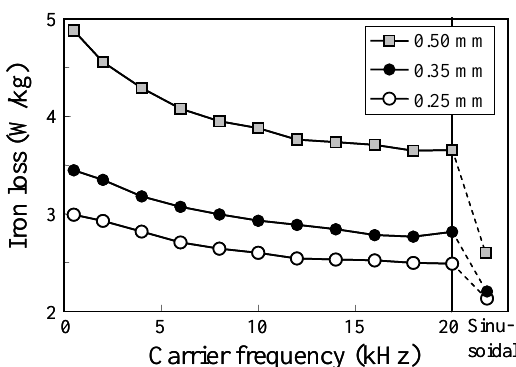
Figure 8. Dependence of iron loss on carrier frequency under PWM excitation. Maximum flux density: 1.5 T, fundamental frequency: 50 Hz, modulation index: 0.4.